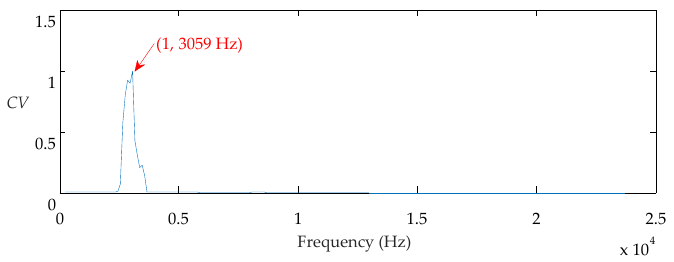
Figure 15. The raw signal of the ball fault bearing: ( a ) time waveform and ( b ) FFT spectrum. The impulse component cannot be directly observed in both. The proposed method is applied to process this signal. First, the center frequency of the ORFB is 3059 Hz based on the CV index, which is shown in Figure 16.